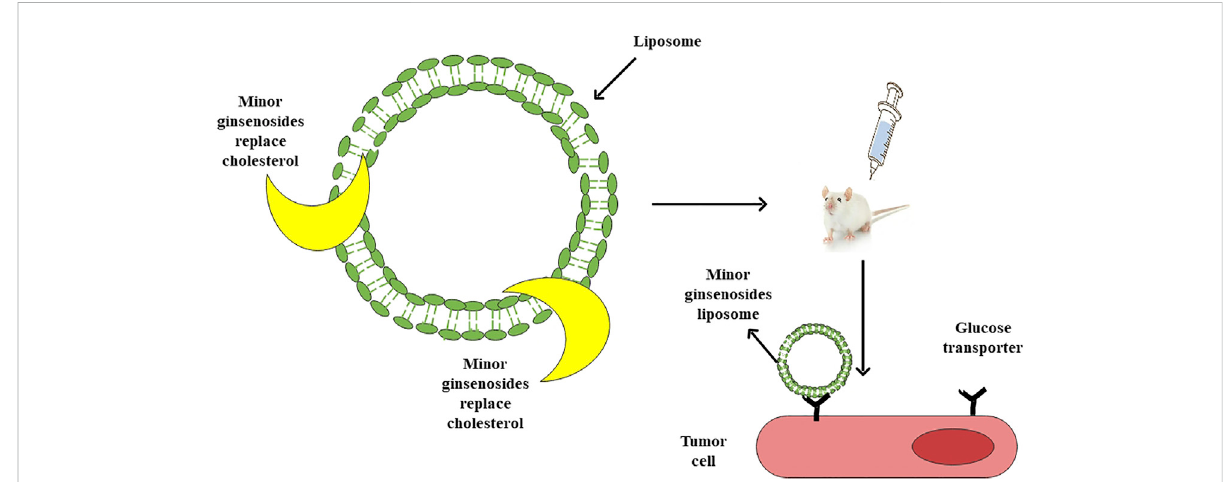
FIGURE 3 Minor ginsenoside liposome drug delivery system and mechanism of tumor-targeted therapy.